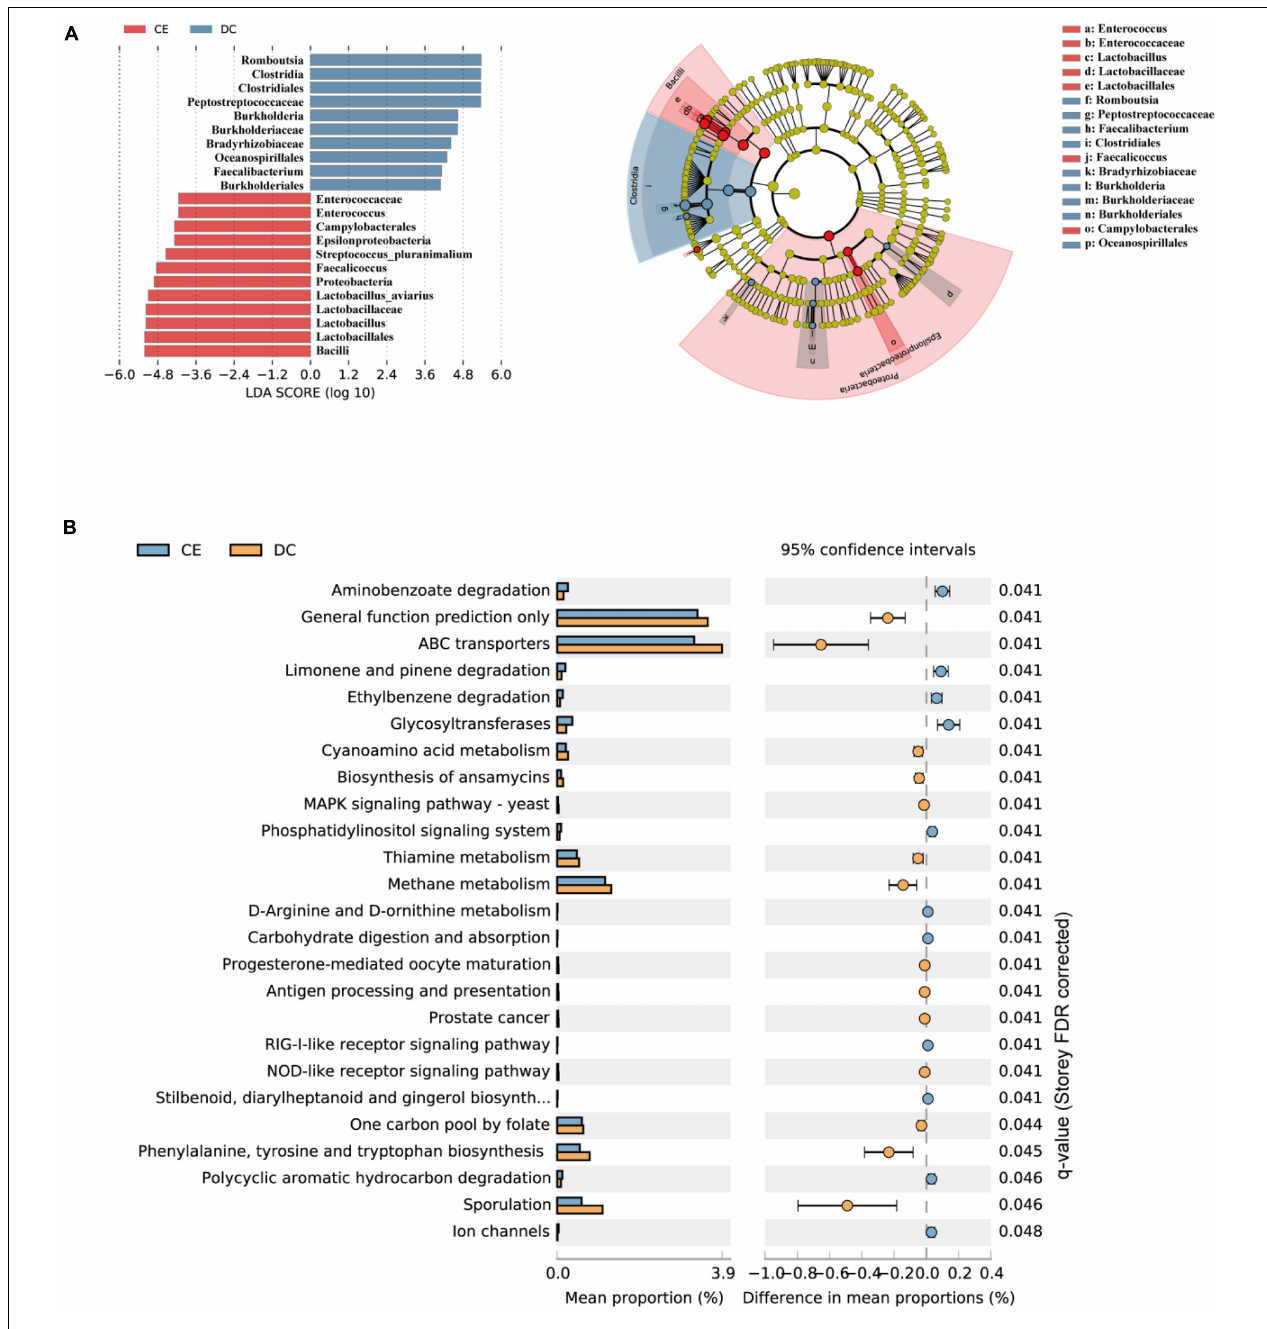
FIGURE 4 | DC and CE have differential bacteria composition and functional preferences ( n = 6 hens/group). (A) LEfSe analysis was performed to identify the bacteria that are differentially represented among the two groups. (B) Microbial functional analysis was conducted by PICRUSt software under different experimental